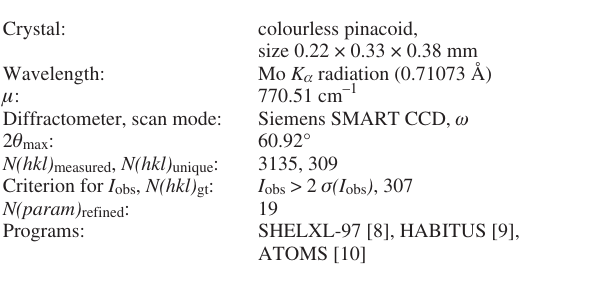
Table 1. Data collection and